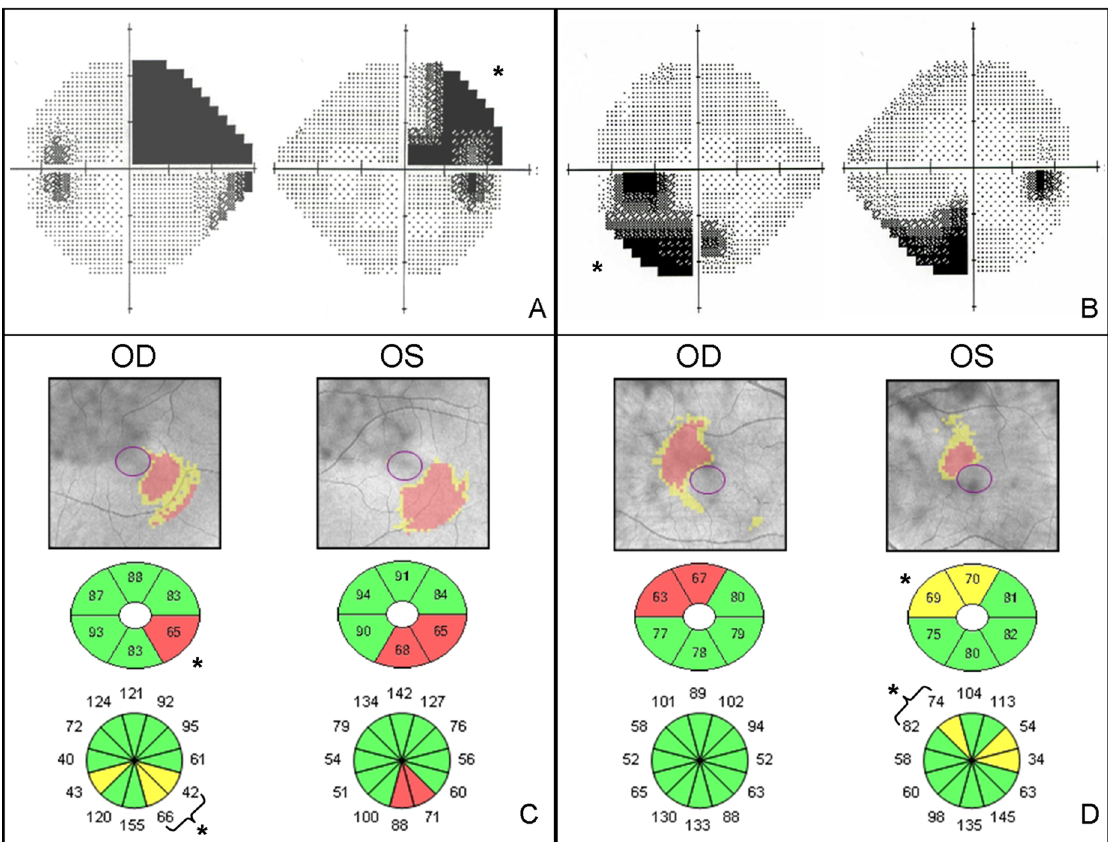
Figure 1. VF greyscale plot (A, B), RGC and RNFL thickness (C, D) of patient 3 (A, C) and patient 6 (B, D). * Sample correlated OCT segments with corresponding VF quadrant.